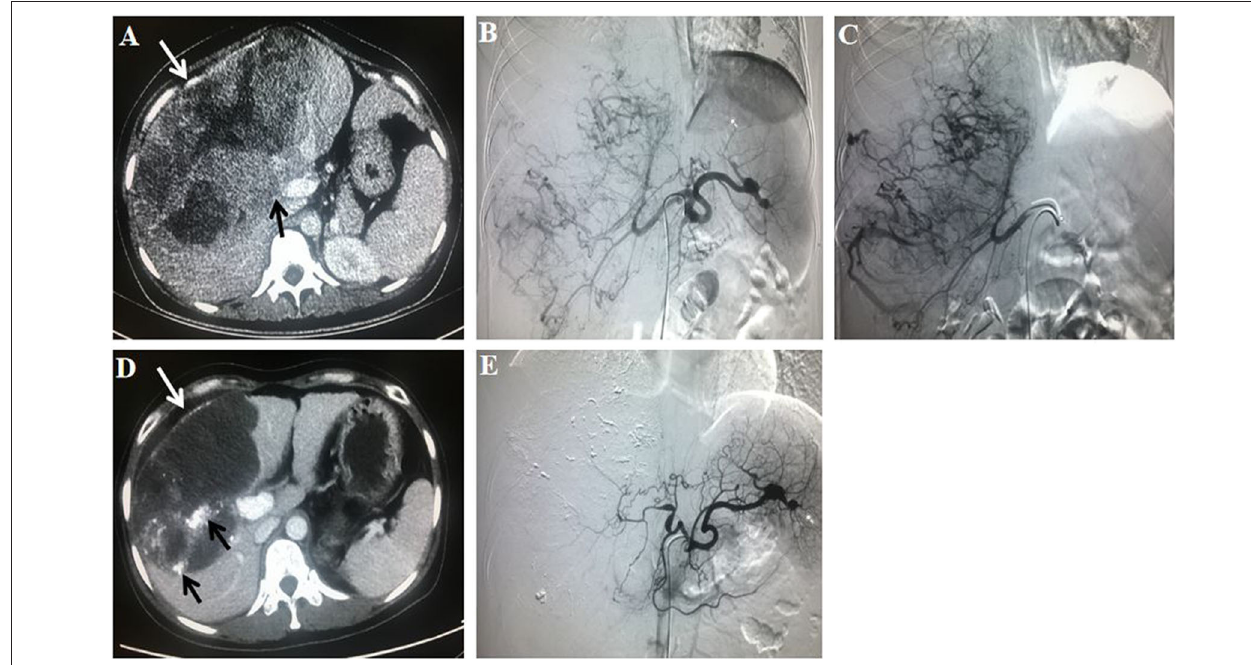
FIGURE 2 | A 31-year-old female patient with Barcelona Clinic Liver Cancer stage C hepatocellular carcinoma who had a history of hepatitis B virus received transarterial chemoembolization (TACE)–apatinib treatment. The initial value of a-fetoprotein (AFP) was 570 ug/L. (A) A contrast-enhanced CT scan before the first TACE procedure showed a massive liver tumor (white arrow; size of 20.6 × 12.9cm) which invaded the right branch of the portal vein (black arrow). (B) An angiography in the celiac trunk artery showed a mass of tumor-feeding arteries. (C) An angiography in the right hepatic artery showed that the tumor vessels were dilated and tortuous. (D) At 3 months after TACE–apatinib treatment, a contrast-enhanced CT scan showed that the tumor (white arrow), with lipiodol accumulation (black arrow), was significantly shrank (15.0 × 9.5cm), and there was no enhancement within the tumor. (E) At 3 months after TACE–apatinib treatment, an angiography confirmed that there was no tumor in the liver. Tumor response according to the modified response evaluation criteria in solid tumors was complete response. Meanwhile, the value of AFP was decreased to normal (10.3 ug/L).